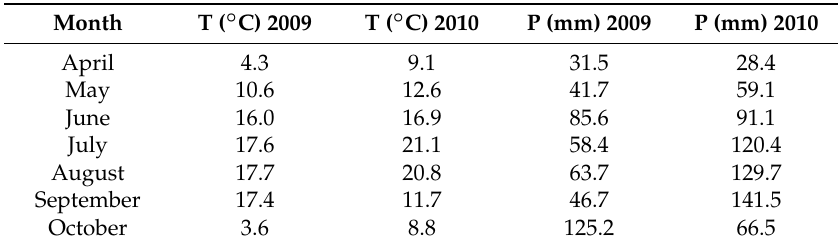
Table 4. Mean monthly temperature (T) and precipitation (P) data for our study area during the months of R S measurement in 2009 and 2010